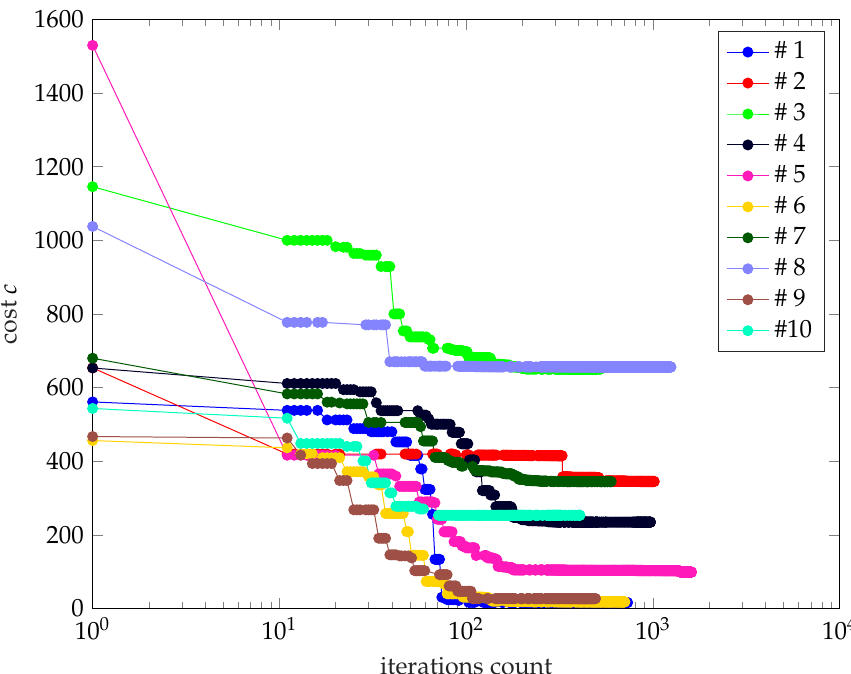
Figure 13. Cost versus function calls. Different starting points are denoted with different colors.